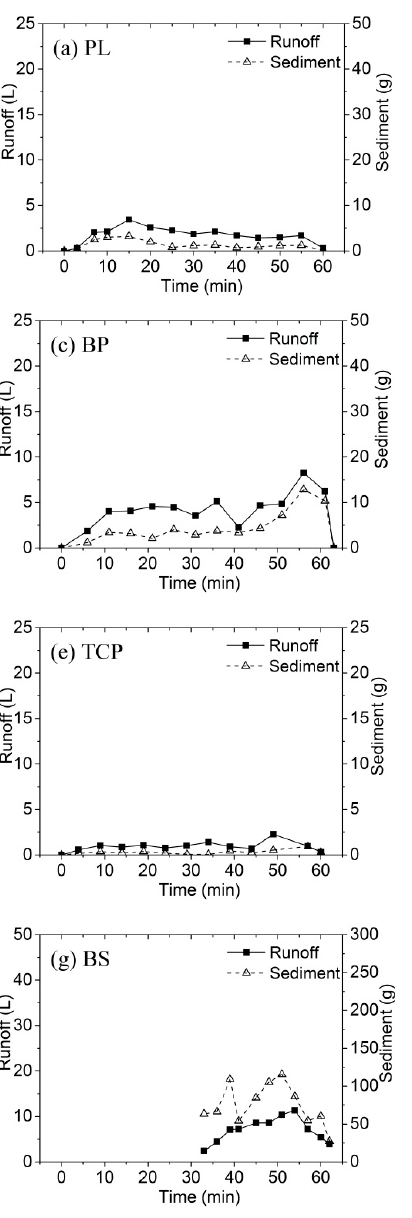
Figure 5. Runoff and sediment yields under different land cover and tillage conditions.